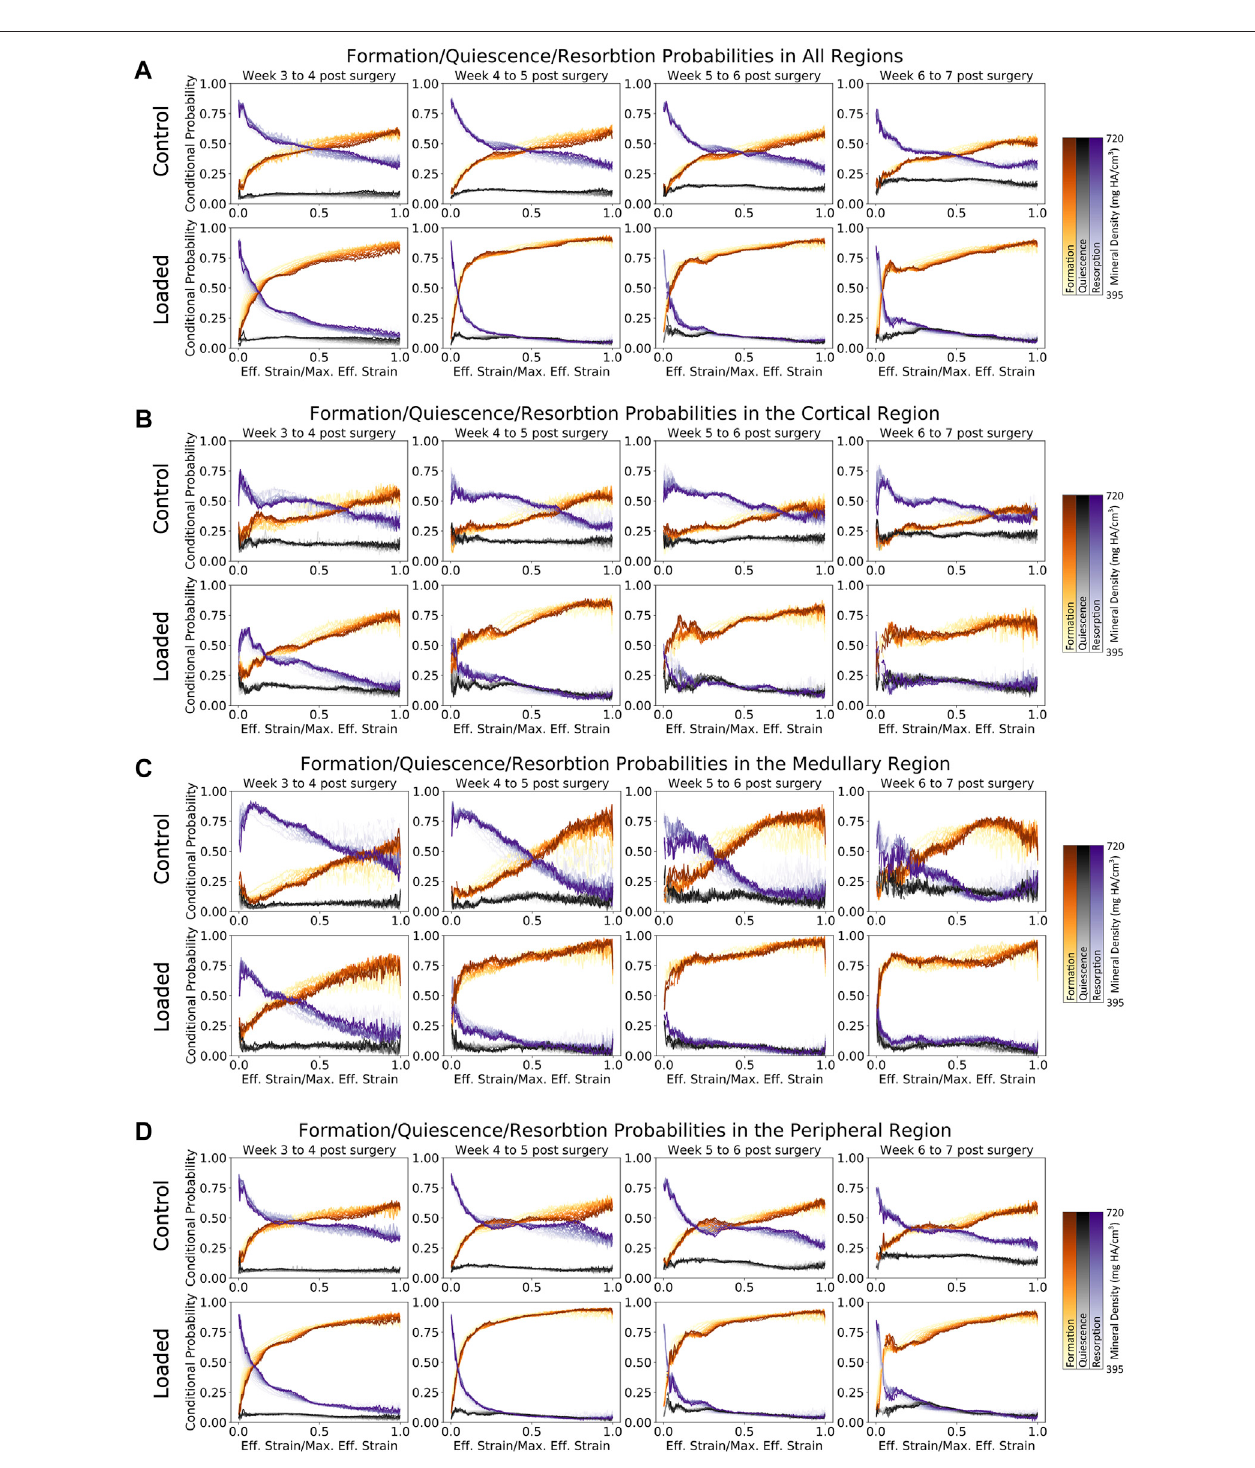
FIGURE 5 | Conditional probability of formation/quiescence/resorption based on effective strain in femur defect regions. (A) Formation and resorption show clear mechano-regulationforalltimepoints. (B) Corticalregionsshowlessmechanosensitivityinearlytimepointsintheloadedgroup,whilethecontrolgroupshowsthatvery highstrainsarerequiredbeforeformationismostlikelytooccur. (C) Similartothecorticalregion,theloadedgroupshowsincreasingmechanosensitivitytowardweek7. (D) In the peripheral region of the loaded group, it is evident that during the earlier time points, lowly mineralized tissue is more likely to form than highly mineralized tissue for voxels under effective strains up to half of the maximum effective strain.